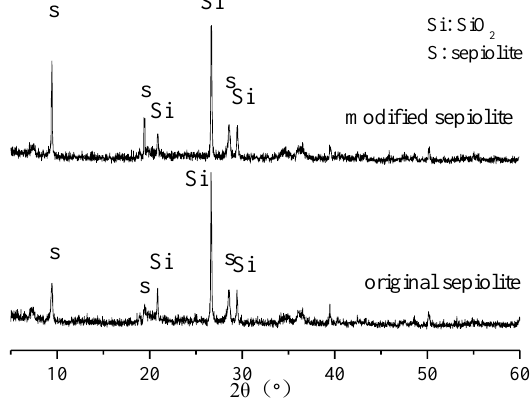
Figure 3. X-ray diffraction spectrum of original sepiolite and modified sepiolite.